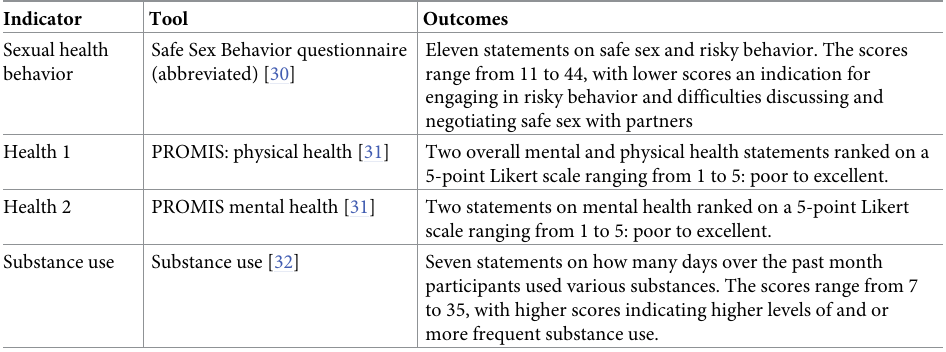
Table 1. Indicators, tools, and outcomes.